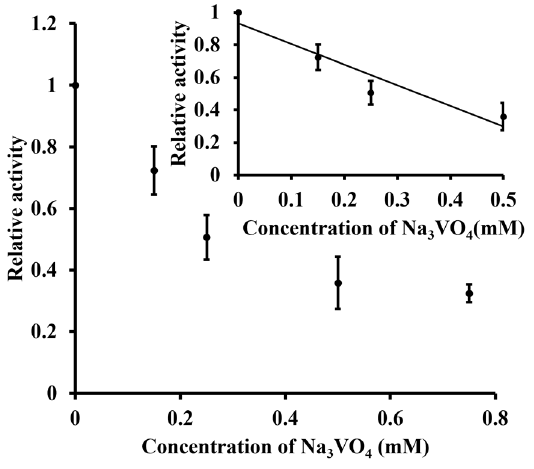
Figure 5. The inhibitory effects of Na 3 VO 4 (0, 0.15, 0.25, 0.5, and 0.75 mM) on ALP. Concentration of ALP was 5 U/L. Inset: calibration linear curve for the inhibitory effects of Na 3 VO 4 on ALP.